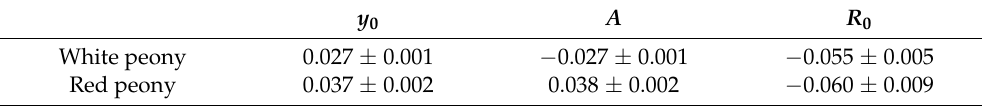
Figure 7. Experimental results of THz SPR biosensor for white peony and red peony. ( a , b ) Sample images. ( c , d ) Test results of white peony and red peony on THz SPR biosensor. ( e , f ) Corresponding frequency shift of mass function of white peony and red peony. Each data set is marked with a standard deviation. Table 2. Parameters values corresponding to the fitting curves of white peony and red peony.